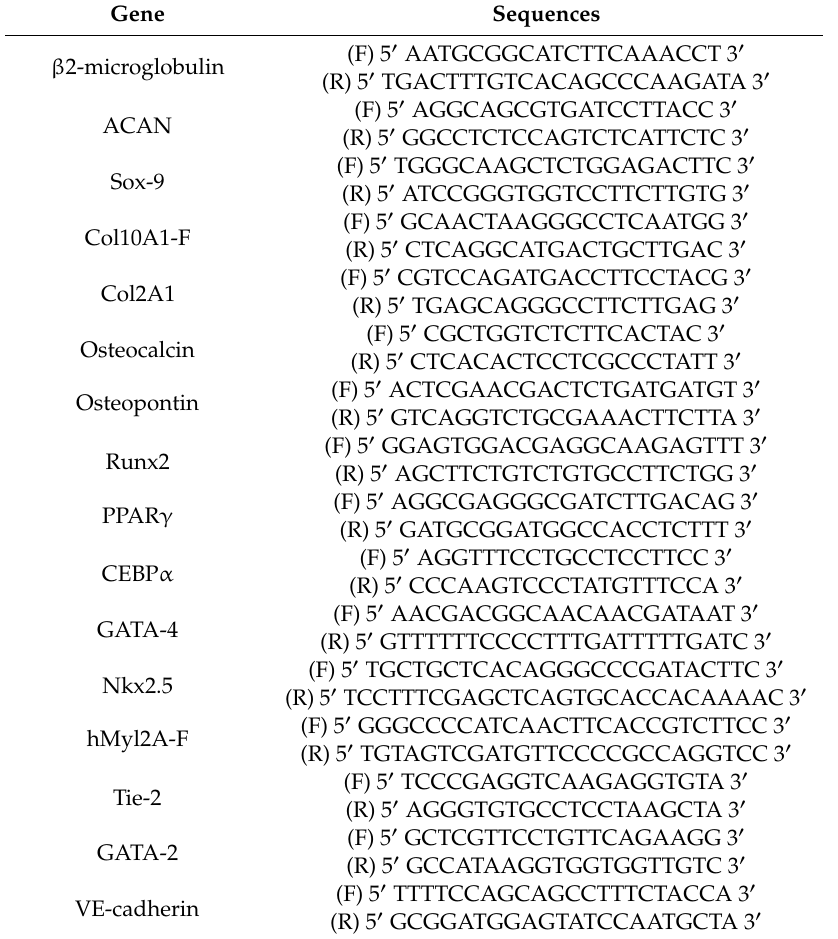
Table 1. List of primers employed in real-time